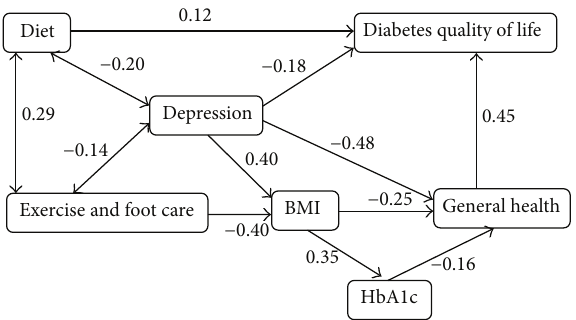
Figure 1: Final SEM with standardized coefficient weights on the associations between psychosocial and physiological factors and diabetes health indicators in Asian and Pacific Islander adults with type 2